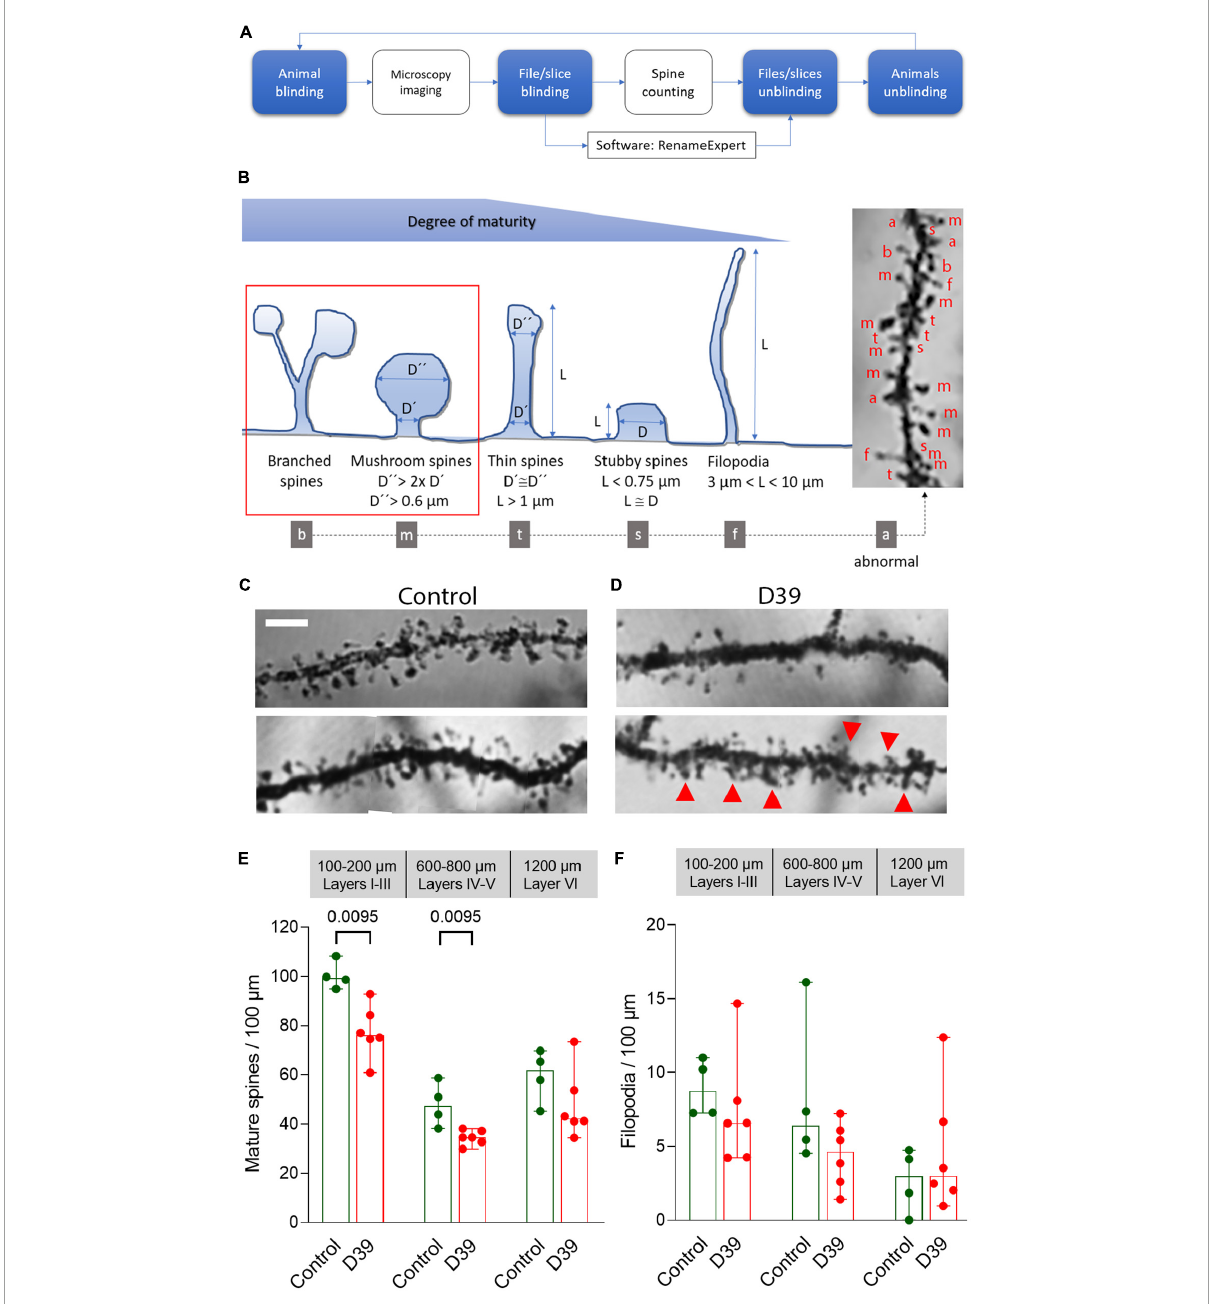
FIGURE4 Dendritic spine loss and pathologic spine morphology in meningitis animals. (A) Schematic workflow diagram of the evaluation of dendritic spines with two steps of sample blinding to reduce subjectivity. (B) Major dendritic spine morphologies and criteria we used for classification of mature and immature spines (see section “2. Materials and methods”) with examples of different types of spine identification (on a silver impregnation tissue sample right). (C) Normal morphology of the spines on secondary branches of the apical dendrite of pyramidal neurons in layer 4. Most spines are mature, exhibiting a mushroom form with a well-defined head and neck; dendrites demonstrate regular morphology with parallel borders. Scale bar: 5 µ m. (D) Eighteen hours after initiation of meningitis and 12–15 h after the onset of symptoms, dendrites demonstrate reduced numbers of spines in the somatosensory cortex (S1-S2). Abnormal protrusions/not identifiable structures are indicated with red arrows. All images represent a single layer overlay of the stacks, used for spine analysis (see Supplementary Figure 4 ). (E) Significantly reduced numbers of mature dendritic spines with normal morphology through layers 1–5. (F) Filopodia, representing immature spines, remain unchanged through the cortex in the meningitis animals versus healthy controls. All values represent median ± 95% CI, Mann-Whitney U-test, exact p -value is presented on the graph (if below 0.05). The number of animals in each group is indicated by the symbol points in the scatter plot [for mock-infected animals (control), n = 4 animals, for D39-infected mice (D39), n = 6], each group contains equal numbers of male and female